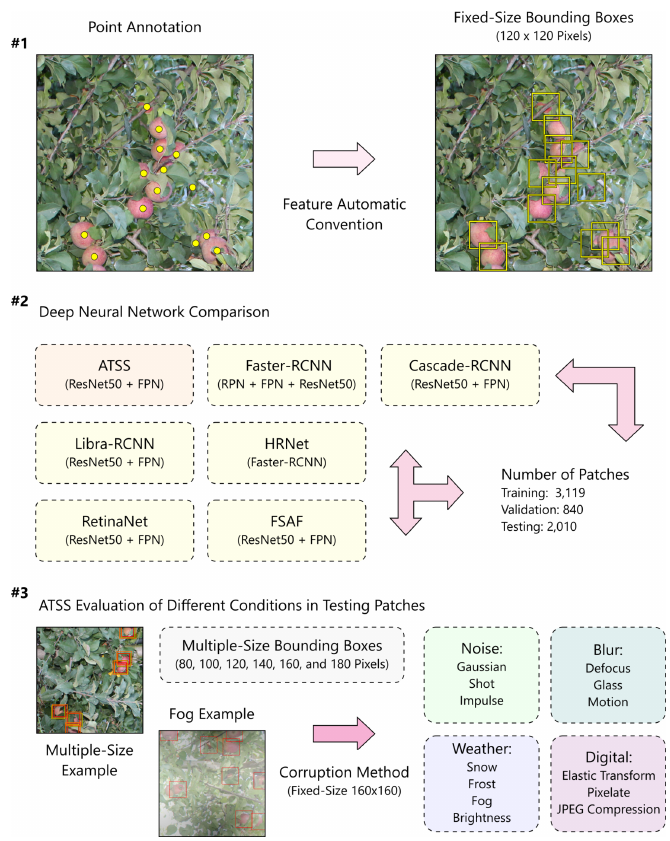
Figure 3. The workflow for apple-fruit detection divided into three main steps: ( #1 ) annotation pro- cess, ( #2 ) image patches distribution into training, validation, and test, and the methods applications and comparison and ( #3 ) image corruption